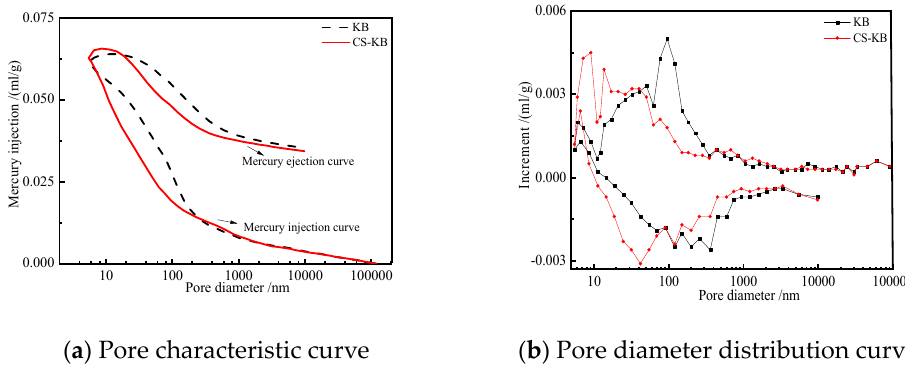
Figure 12. Curves of pore distribution characteristics of mortar before and after sulfate attack.